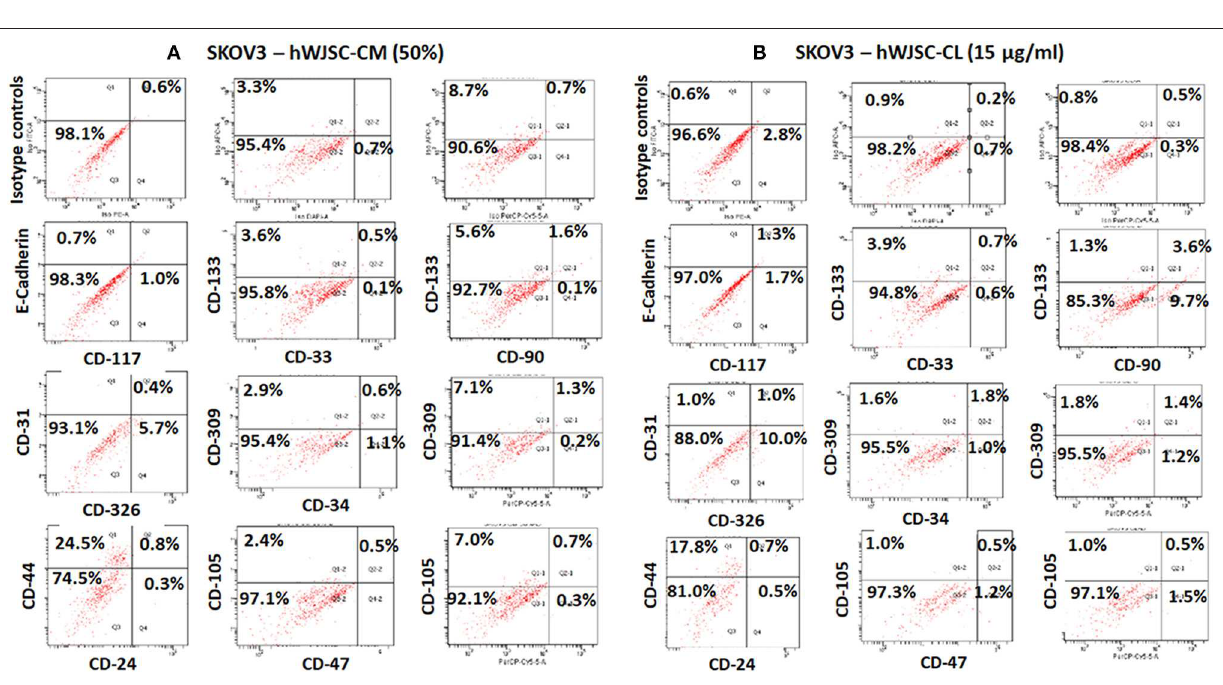
FIGURE 11 | Representative histogram of the cancer stem cells (CSC) related CD surface markers in tumor spheres (TS) of (A) SKOV3 treated with hWJSC-CM (50%) and (B) TS of SKOV3 cells treated with hWJSC-CL (15 µ g/ml using flrorescent activated cell sorting (FACS). Positive expression for some of the CSC markers were observed in the TS of SKOV3 treated with hWJSC-CM and hWJSC-CM for